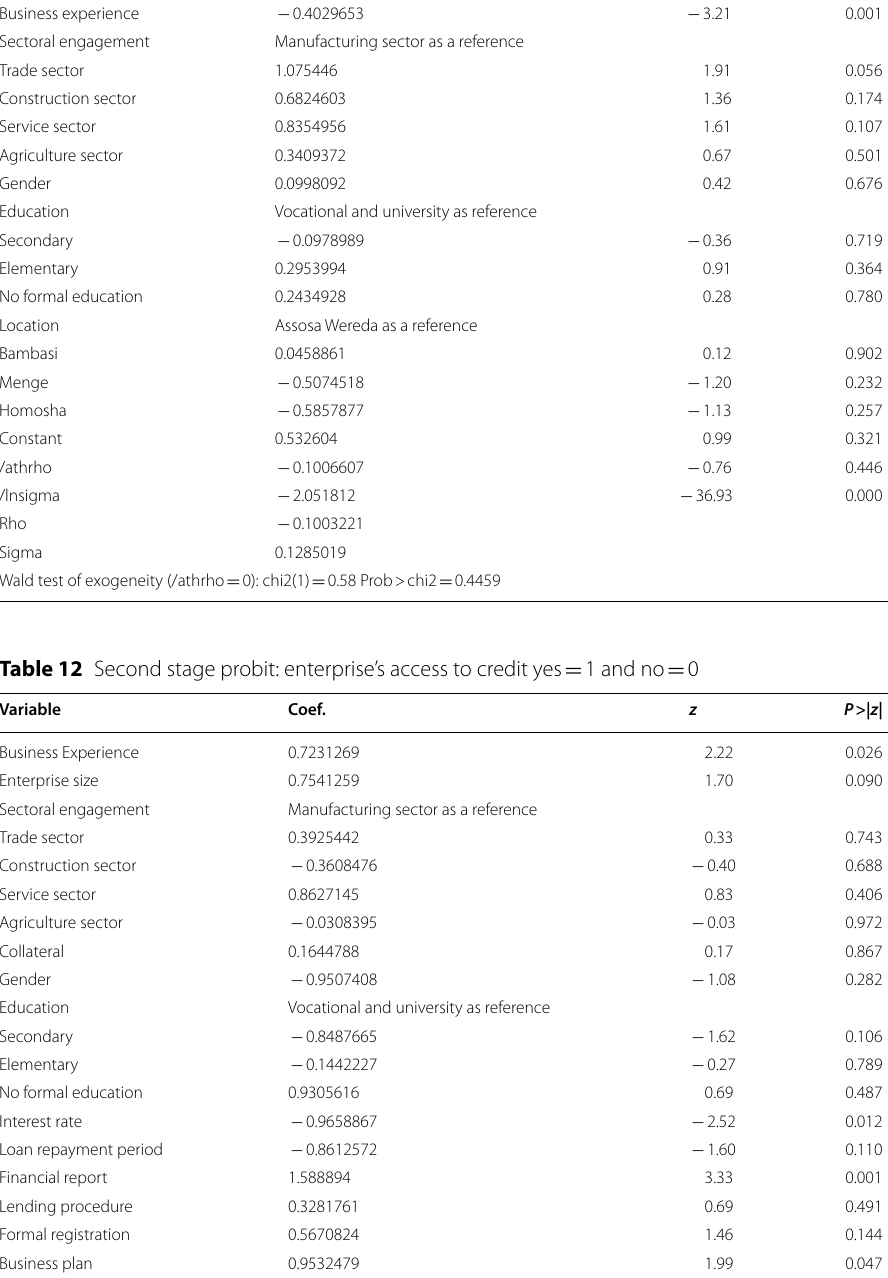
Table 11 First stage IV-probit, enterprise size where small Variable Coef.